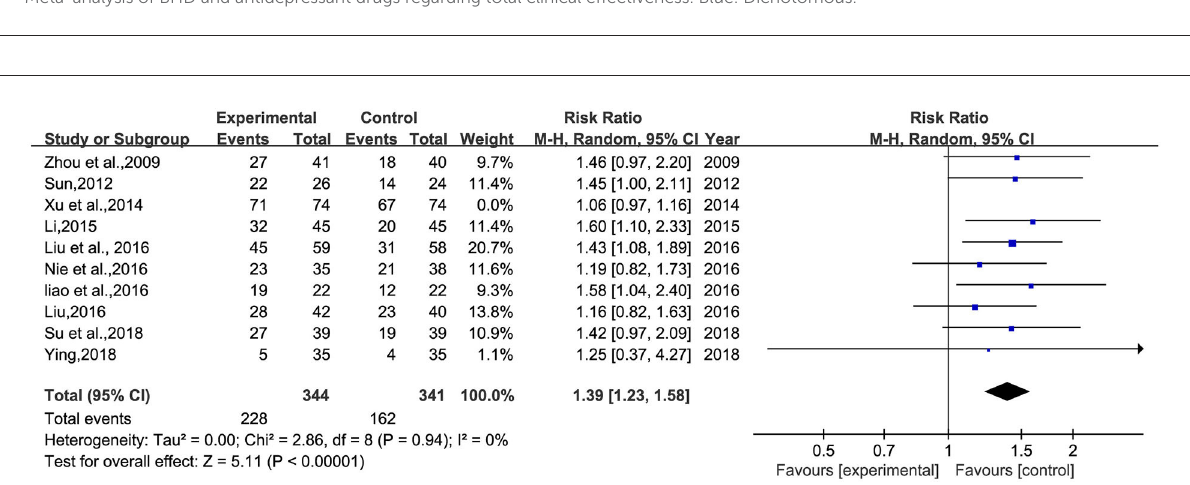
FIGURE6 Meta-analysis of BHD and antidepressant drugs regarding total clinical effectiveness (9 items). Blue: Dichotomous.